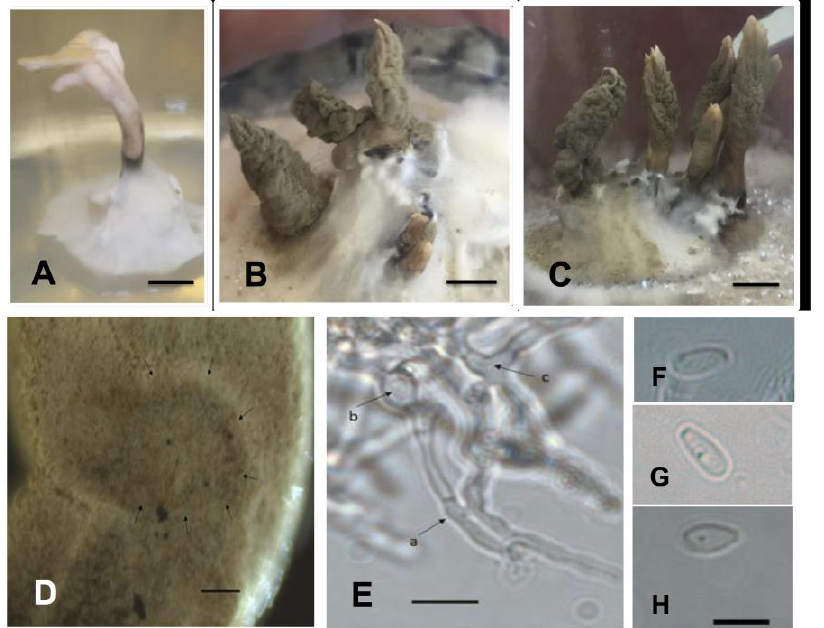
Figure 5. Isolated Xylaria sp. 1. (HBEI 021) ( A – C ). Stromata obtained in culture on MEA 2% medium; ( D – F ). Bright-field microscopy; ( D ). Initial formation perithecia (arrows); ( E ). Hyphae regularly septated (arrow) with branches forming 90° angles (arrowhead); ( F ). Ascospores with longitudinal germ slit (arrow); ( G , H ) Differential interference contrast microscopy (DIC),